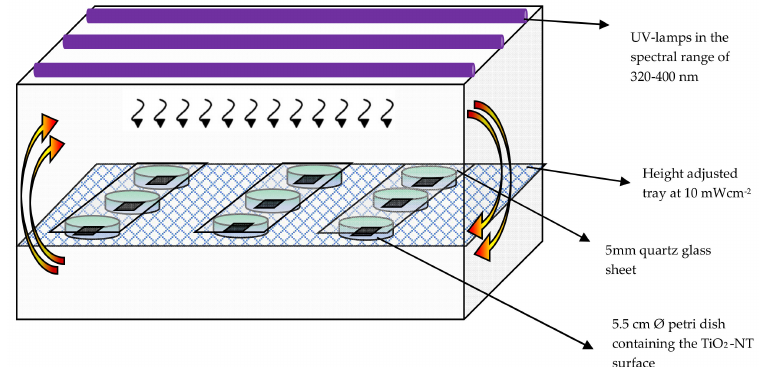
Figure 1. Diagrammatic representation of the experimental set up used for the determination of the redox activity of the titanium dioxide nanotubes (TiO 2 -NT)